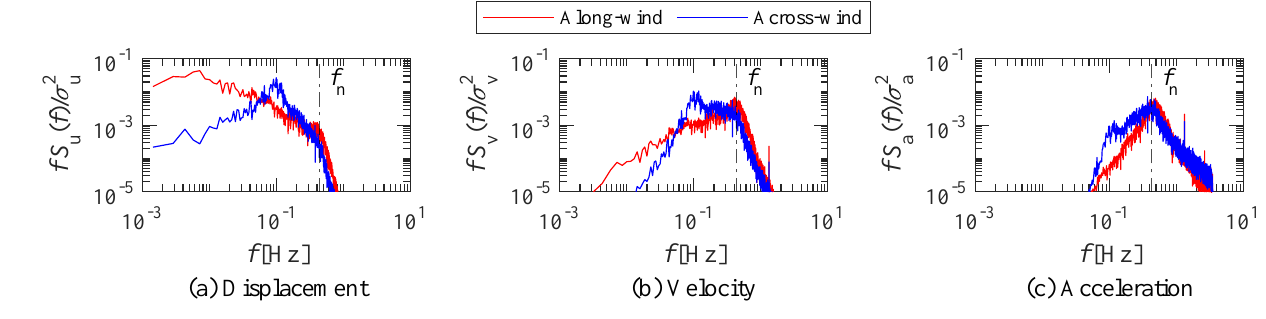
Figure 12. Normalized PSD of wind-induced responses of the FD system (2H-HH).